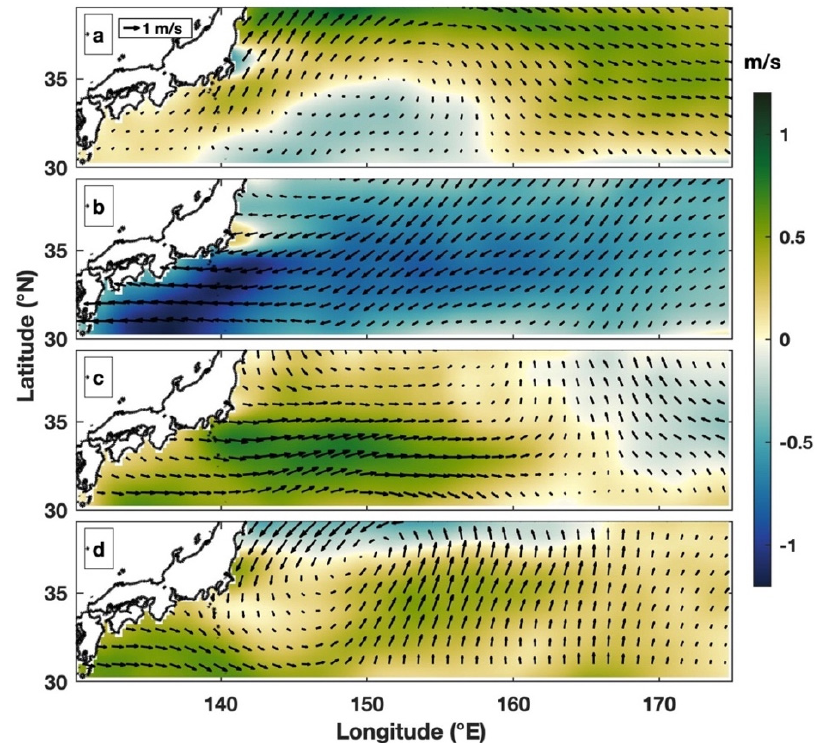
Figure 5. Seasonal changes in wind speed (shading) overlaid with the wind vector (m/s). The seasonal changes are ob- tained by removing the annual average from the seasonal average. The seasons are ( a ) winter (January–March), ( b ) spring (April–June), ( c ) summer (July–September), and ( d ) fall (October–December).